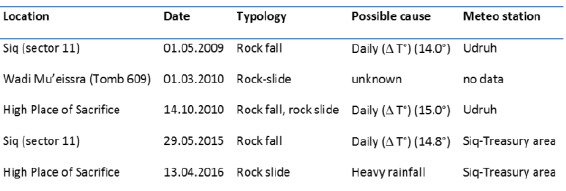
Table 3. Recent landslide events and possible triggering